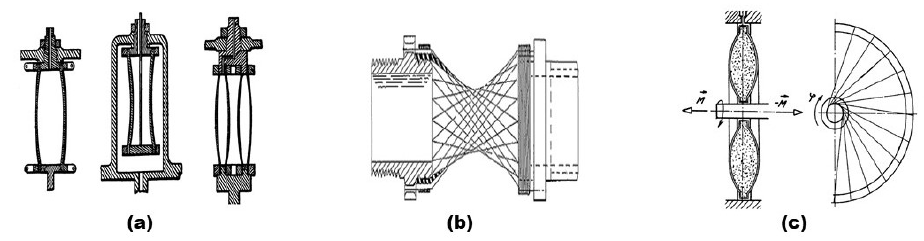
Figure 7. Embedded muscle: ( a ) Morin muscle [25]; ( b ) Paynter Hyperboloid Muscle [19]; ( c ) Kleinwachter torsion device